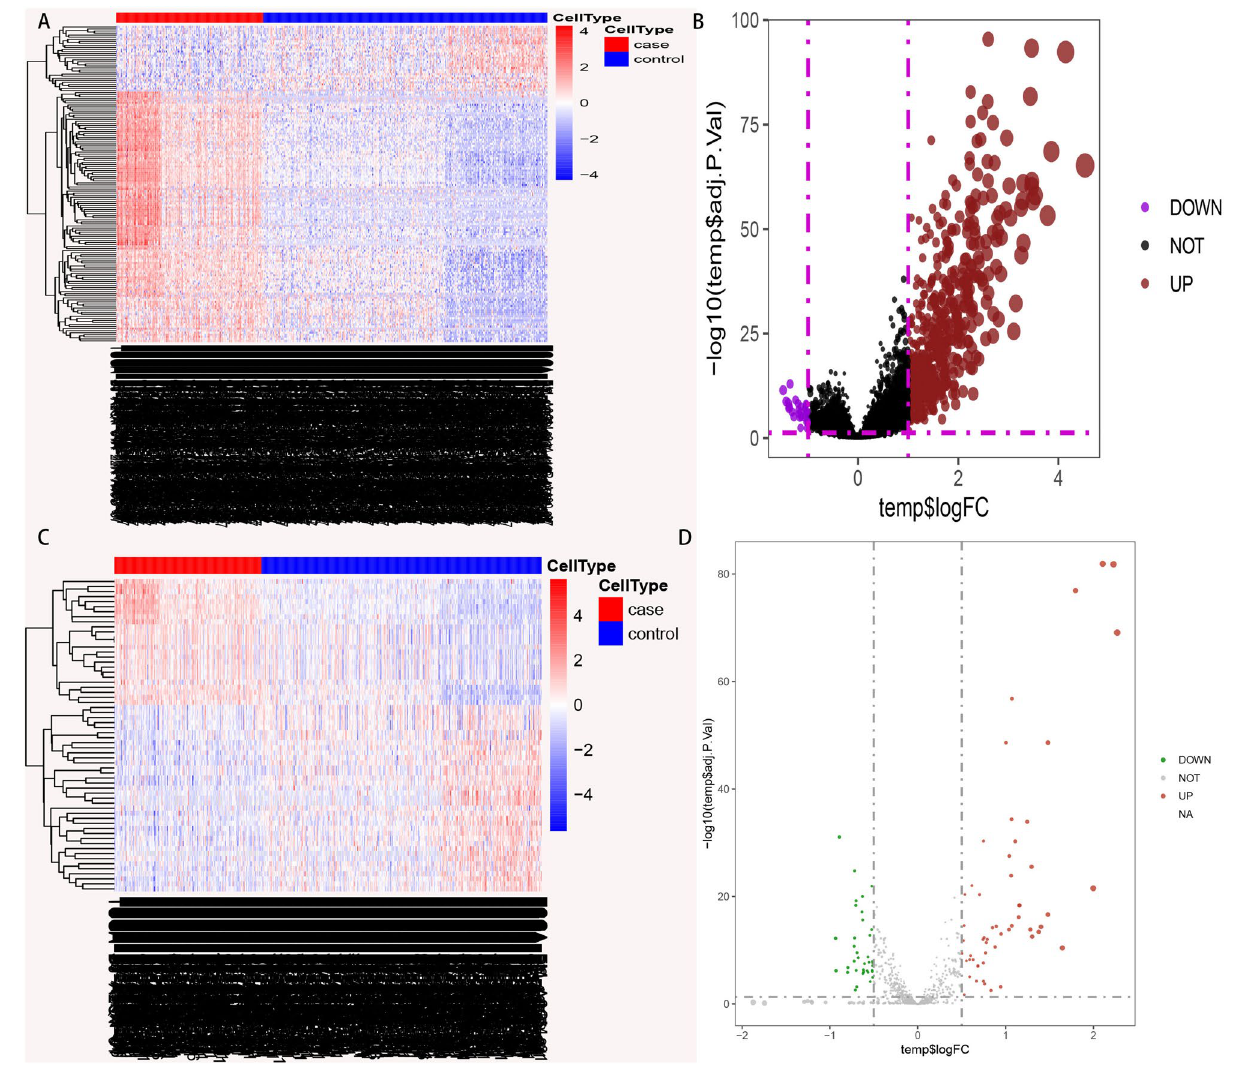
Figure 9. Differences in the expression of lncRNA and miRNA in cold and hot tumors. ( A , B ) Differential expression of lnRNA in cold and hot tumors (|Log2FC|> 1, adjusted p < 0.05). ( C , D ) Differential expression of miRNA in cold and hot tumors(|Log2FC|> 0.5, adjusted p value <